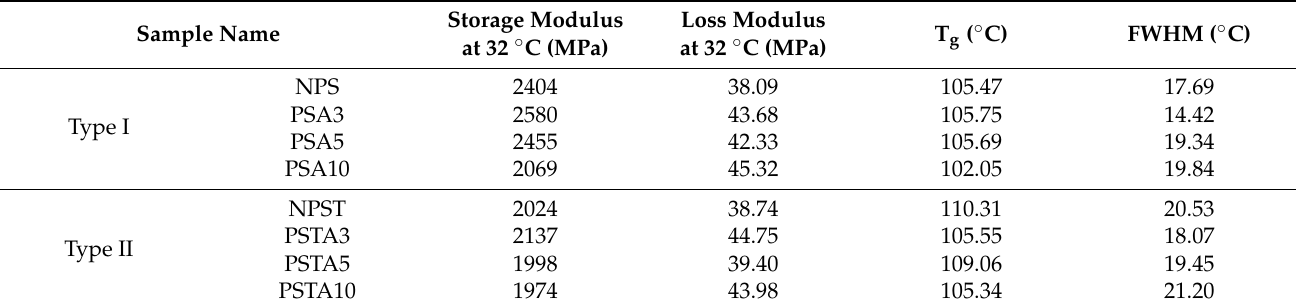
Table 3. The measured viscoelastic properties of samples.